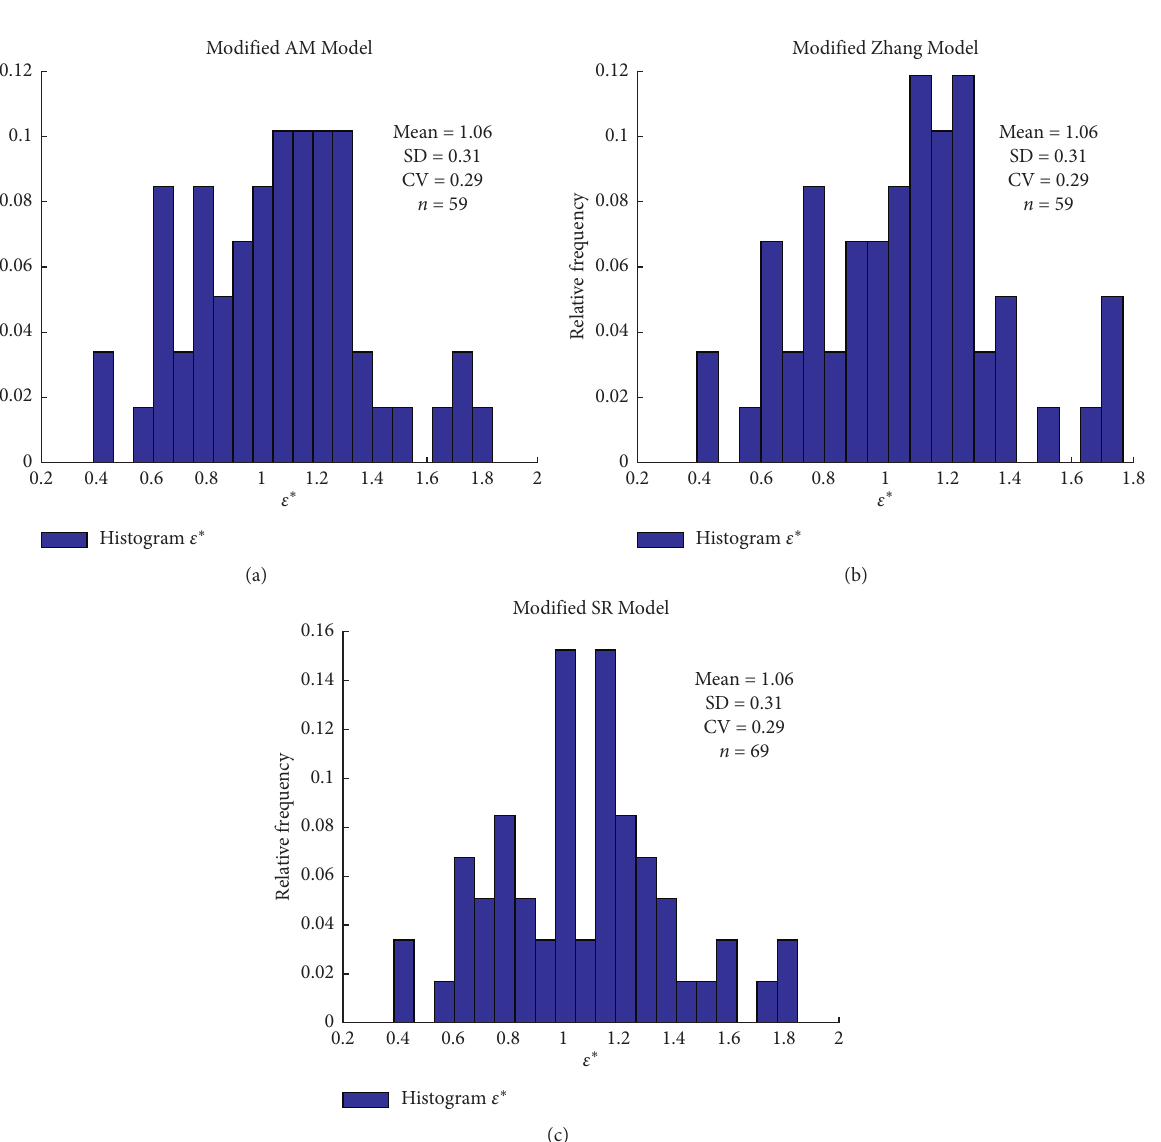
Figure 8: Histogram of ε ∗ for each modified model: (a) AM Model, (b) Zhang Model, and (c) SR Model.